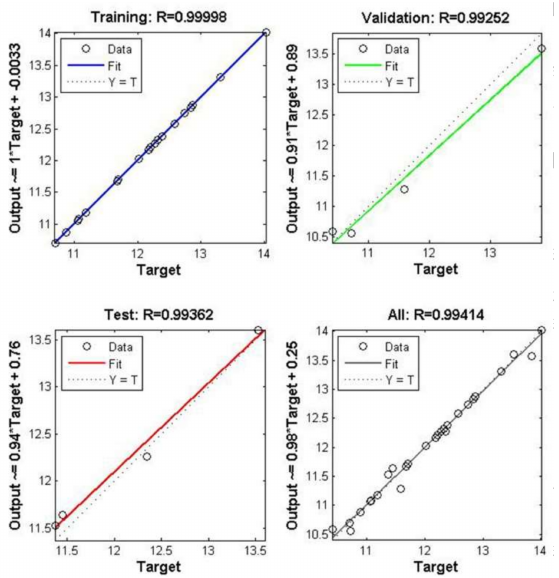
Figure 11. The relationship between the measured and predicted tensile loads of carbon fiber reinforced plastics